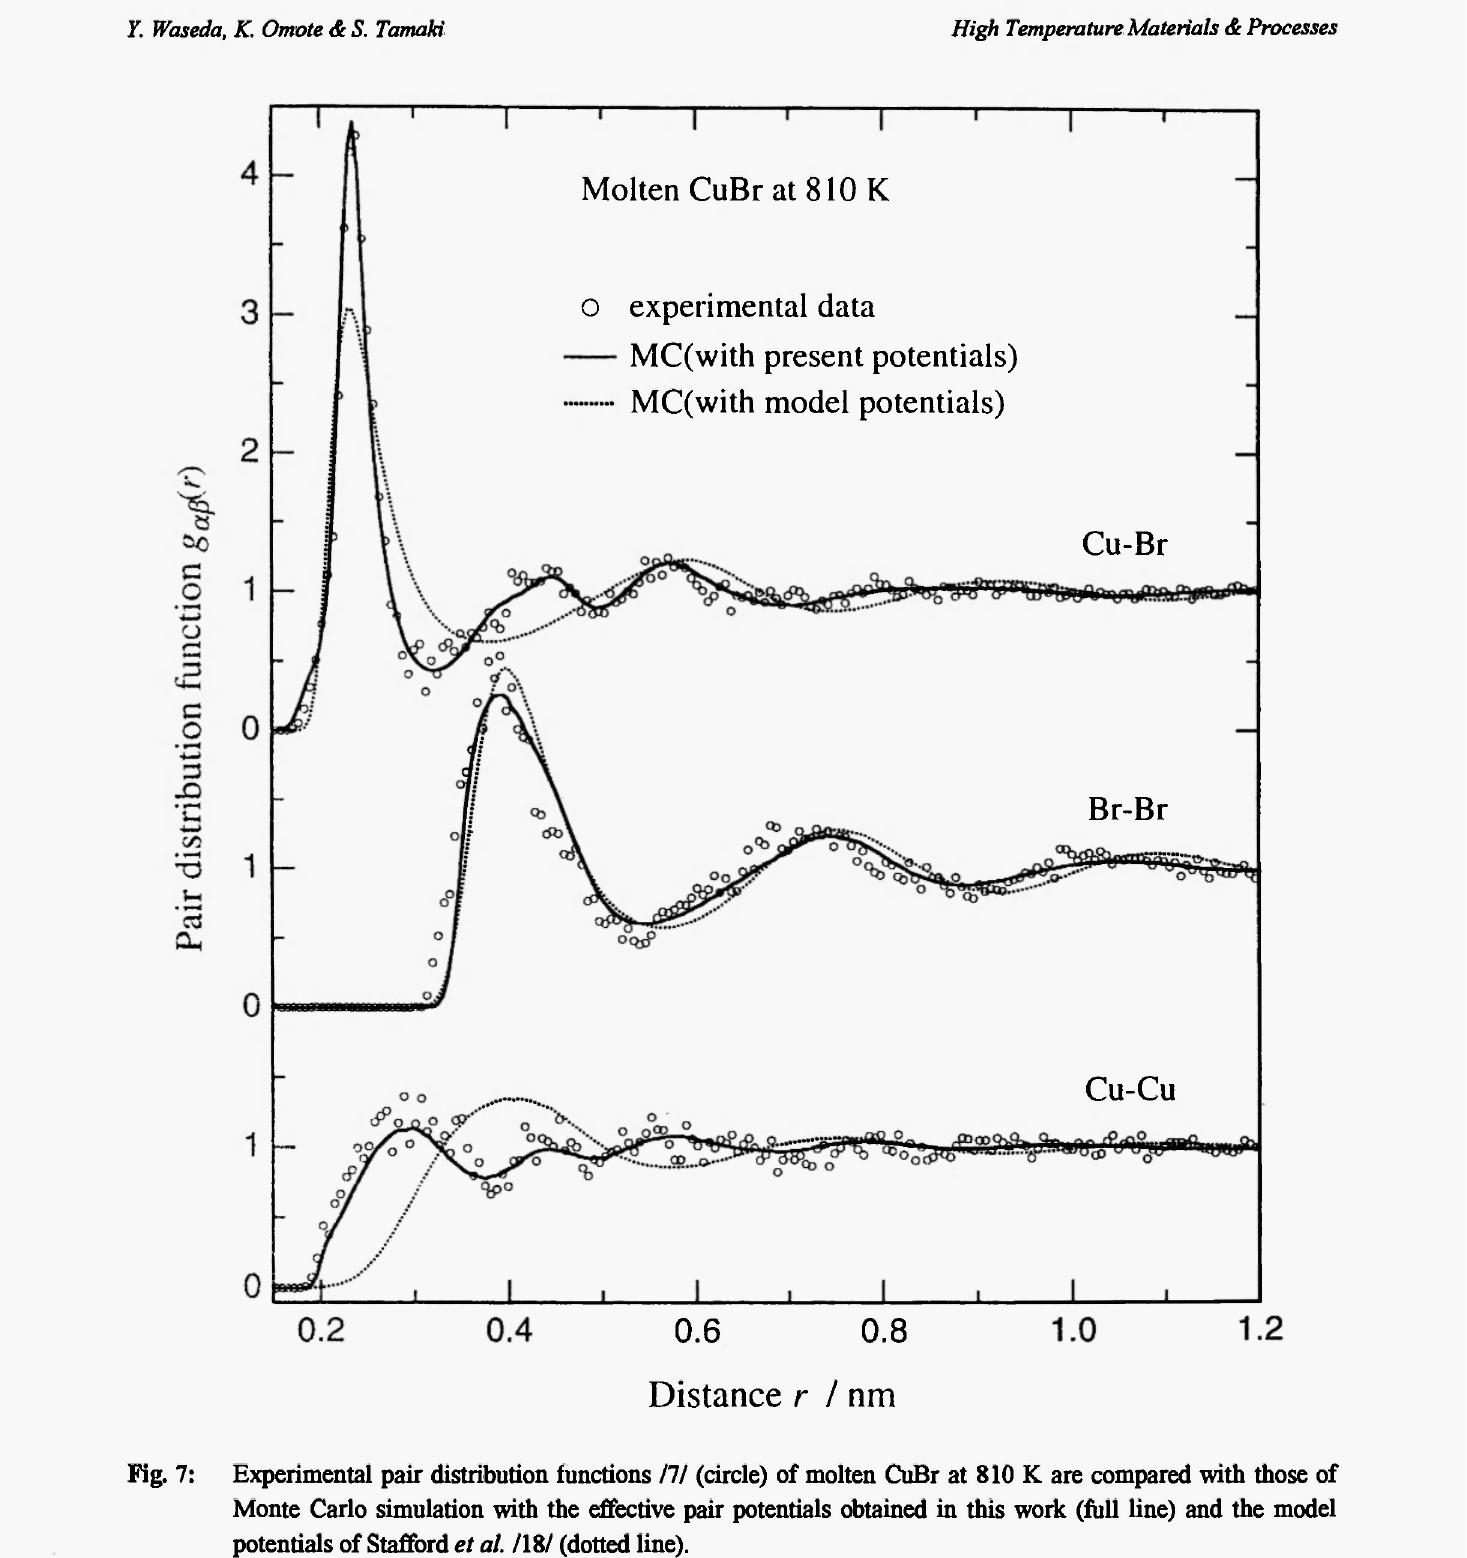
Fig. 7: Experimental pair distribution functions 111 (circle) of molten CuBr at 810 Κ are compared with those of Monte Carlo simulation with the effective pair potentials obtained in this work (full line) and the model potentials of Stafford et al. 718/ (dotted